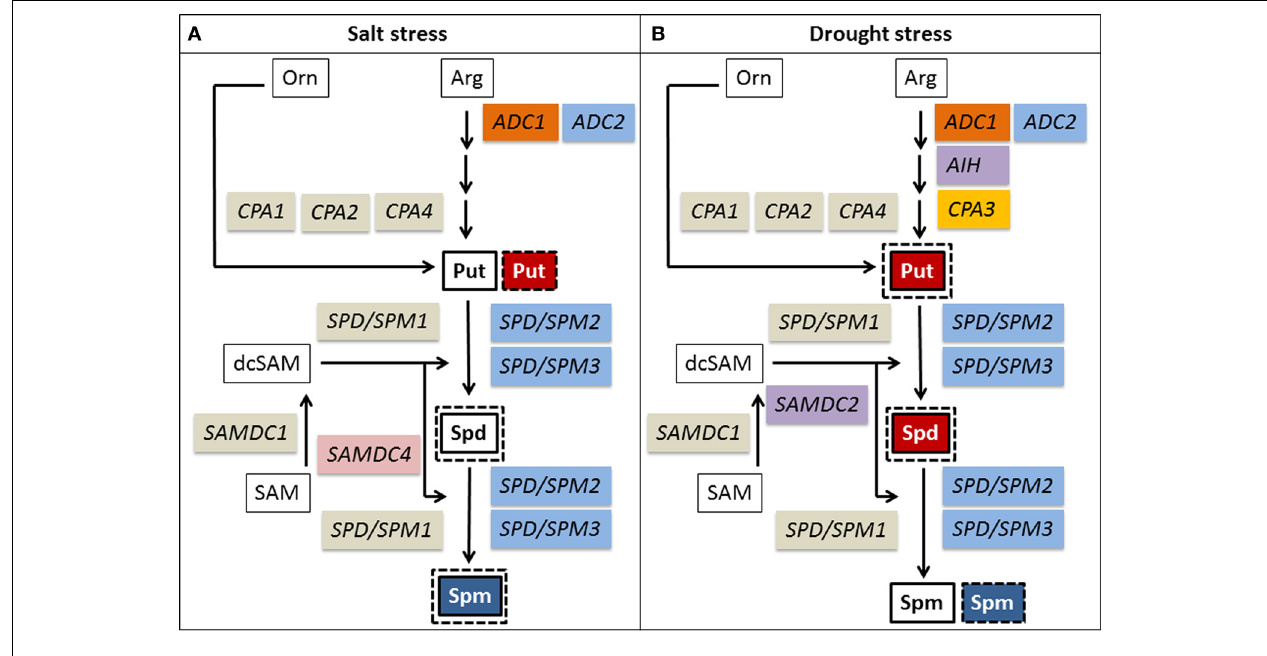
FIGURE 9 | Changes of polyamine metabolism in response to salt (A) and drought stress (B) in rice leaves of tolerant and sensitive cultivars. Changes of polyamines are shown for tolerant (solid line) or sensitive cultivars (dotted line). A decrease is shown in red, an increase in blue. Changes in gene expression under stress conditions are color coded as